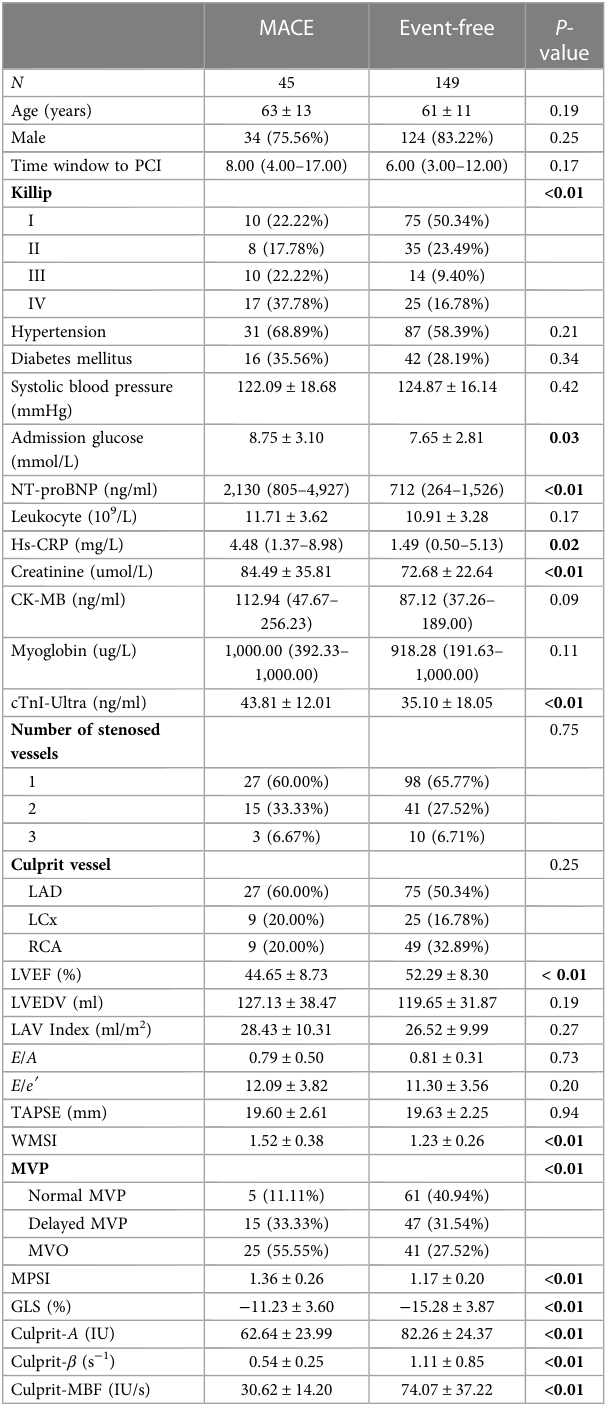
Table 3 . A calibration curve of proposed model is presented in TABLE 1 Distribution of baseline characteristics among clinical